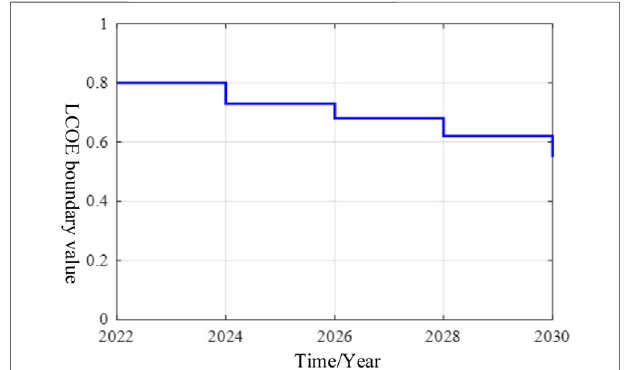
FIGURE 9 | LCOE boundary value.